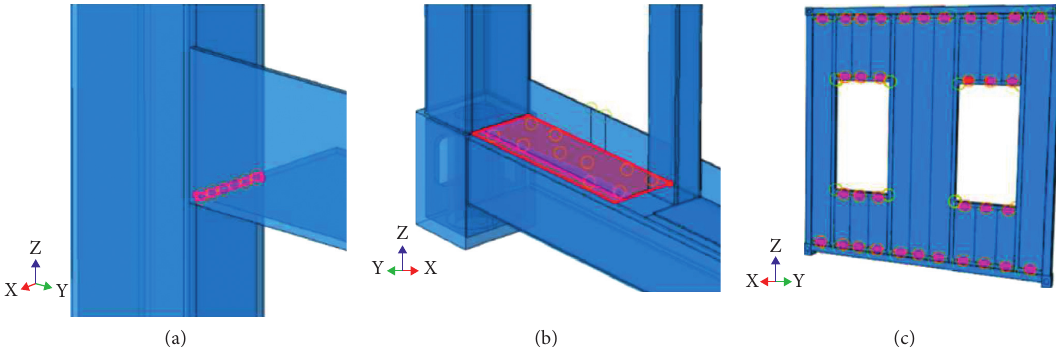
Figure 11: Binding forms of QX-2. (a) Surface binding of angle steel by the window. (b) Surface binding of end angle steel. (c) Point binding for bending shown in Figure 17. By comparing the load-displacement curve of calculation results of QX-2 with the experimental curve, it is shown that the load-displacement curve obtained